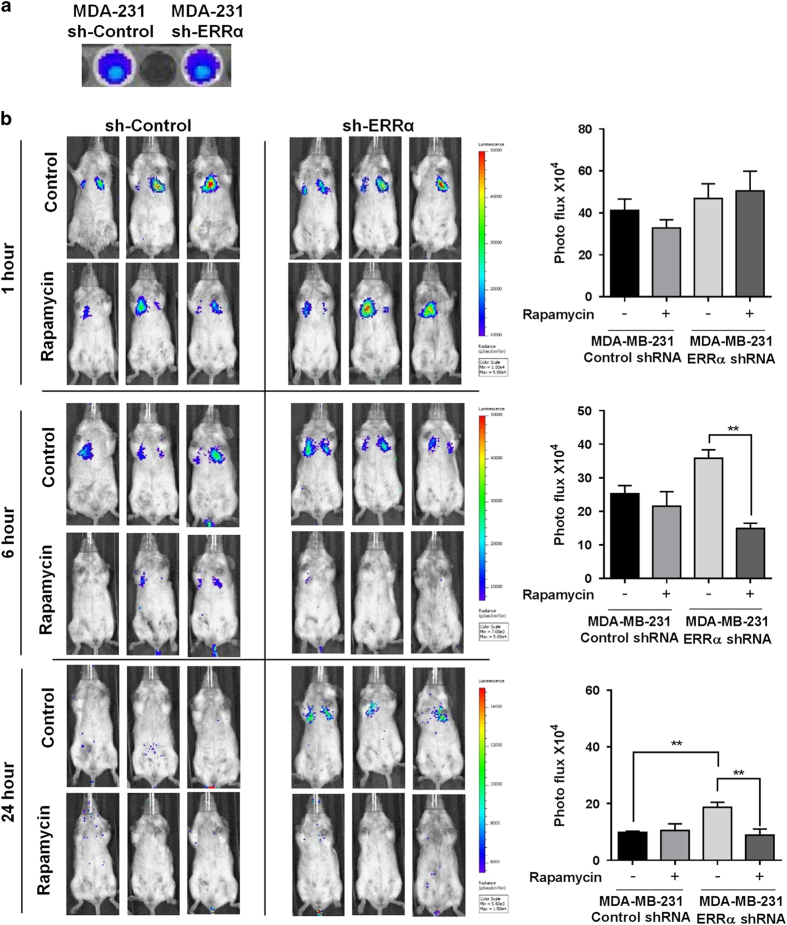
Rapamycin prevents metastasis of MDA-MB-231-sh-ERRα cells in vivo. (a) Representative bioluminescent images of MDA-MB-231 sh-Control and sh-ERRα cells. The total flux (photons per second) of cells is illustrated. (b) MDA-MB-231-luciferase-expressing cells were inoculated intravenously. Representative bioluminescent images of lung colonization at 1, 6 and 24 h post-cell injection are shown. The levels of bioluminescent intensity (total photon flux per second) present in the chest regions were quantified and compared between control18 and treatment groups. Mice were administrated with vehicle or rapamycin (6 mg kg−1, i.p.) 1 h post-cell inoculation. * P<0.05, ** <0.01, Student’s t-test.